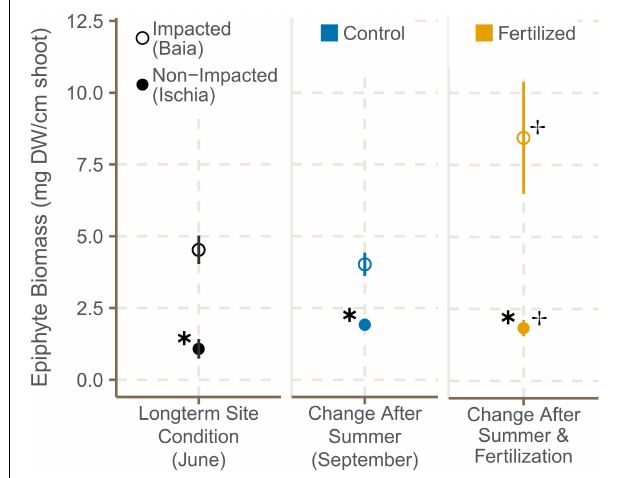
FIGURE 2 | Percentage meadow cover (mean ± SE) of fertilized and control plots in June 2019 and September 2019. (cid:81) Shows significant differences between impacted (Baia) and non- impacted (Ischia) areas. (cid:61) Indicates if there seasonal differences between June and September and (cid:66) states if there are differences between control and fertilized plots.